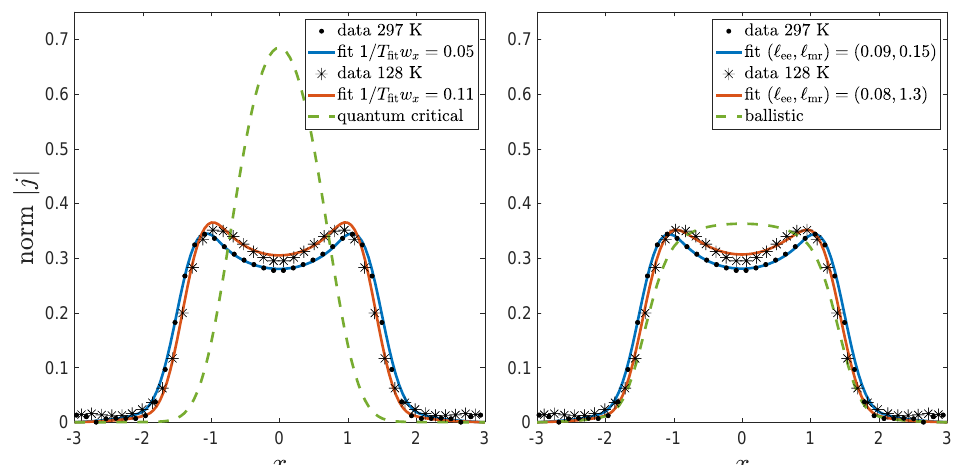
Figure 10: A comparison between holographic (left) and kinetic (right) predictions. The holographic fitting has already been presented in the main text. The solid lines indicate the best fit; while the green curves predicts for a constriction of width 600 nm at experimental temperature T = 128